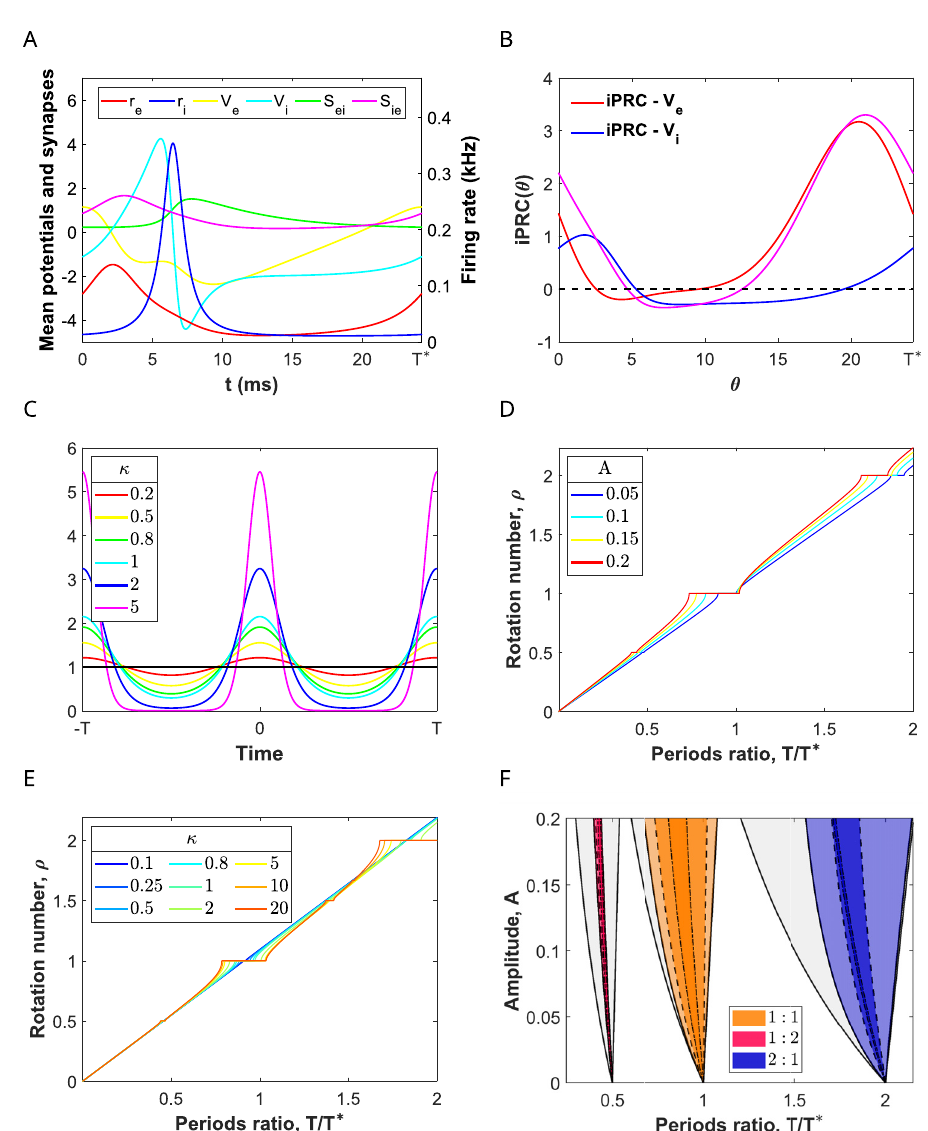
Fig 3. Rotation numbers and phase-locking regions for the forced PING oscillation varying input parameters. (A) Temporal evolution of firing rate, mean membrane potential and synaptic variables over a cycle of a PING oscillation for system (1)-(2) corresponding to the red cross in Fig 2A. (B) Infinitesimal Phase Response Curve (iPRC) for perturbations in the direction of the variables V and V (red and blue curves, respectively) and the sum of them e i (purple curve). (C) Von Mises (circular) distribution as a function of the factor κ controlling the input coherence. Large values of κ result in distributions concentrated around the location μ = 0, whereas smaller values lead to broader low-amplitude distributions. The black horizontal line corresponds to the uniform distribution (limit case attained when κ = 0). (D, E) Rotation numbers of the stroboscopic map (9) for a von Mises input (15) applied in the direction and V , as a function of the ratio between the intrinsic period of the E-I network T � and the input period T . (D) of V e i Rotation numbers for κ = 2 and different amplitude values A . (E) Rotation numbers for A = 0.1 and different input coherence values κ . (F) Arnold tongues computed using the phase reduction corresponding to the 1:1 (orange), 1:2 (purple) and 2:1 (blue) phase-locked states for different input coherence: κ = 20, 2, 0.5 corresponding to the regions delimited by solid, dashed, dash-dotted curves, respectively. In grey, we show the corresponding Arnold tongues for pulsatile inputs ( κ ! 1 ) obtained analytically. See Methods.